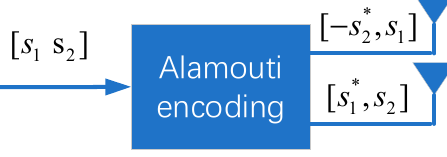
Figure 1. Basic structure of MIMO transmitter.